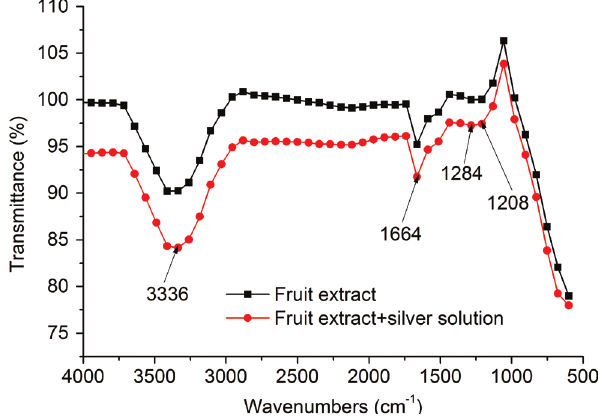
Figure 5: FTIR spectra of samples before and after the treatment producing